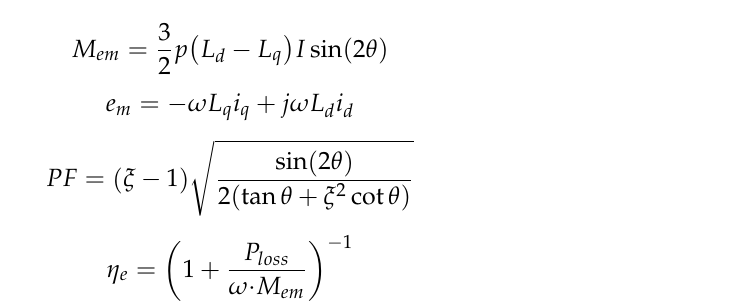
Figure 3. Synchronous reluctance machine (SynRM) vector diagram [19].